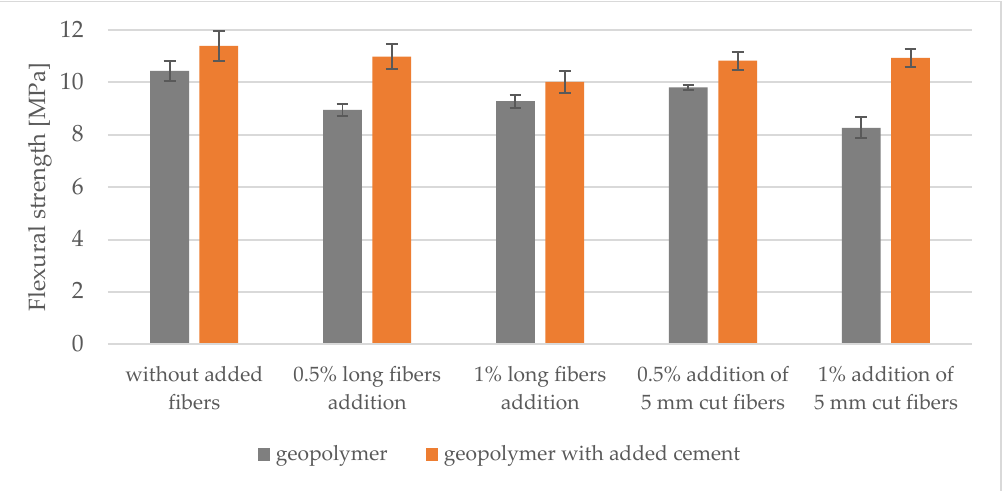
Figure 15. Flexural strength of geopolymers and cementitious geopolymers reinforced with carbon fiber.